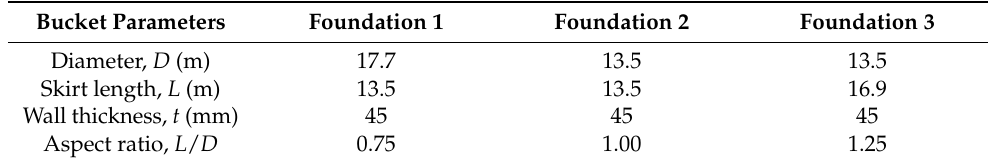
Table 5. Dimensional properties for bucket in comparison